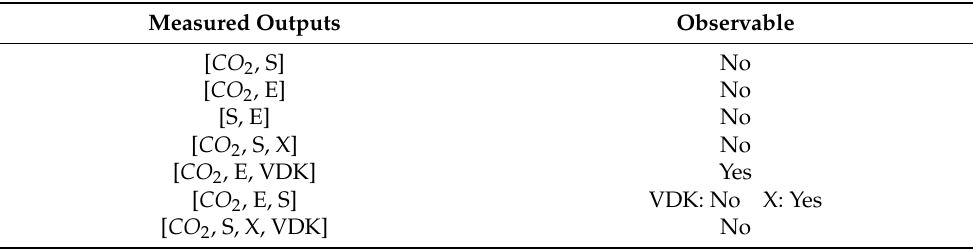
Table 3. Observability analysis of the biomass model for several measurement configurations.